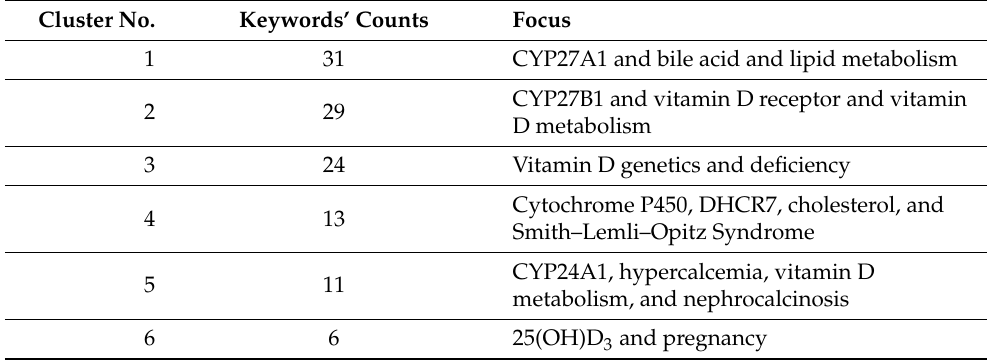
Table 2. Summary of the largest 19 clusters of vitDMGPs articles with top terms mentioned (latent Table 3. The main vitDMGPs research topics according to keywords. Cluster